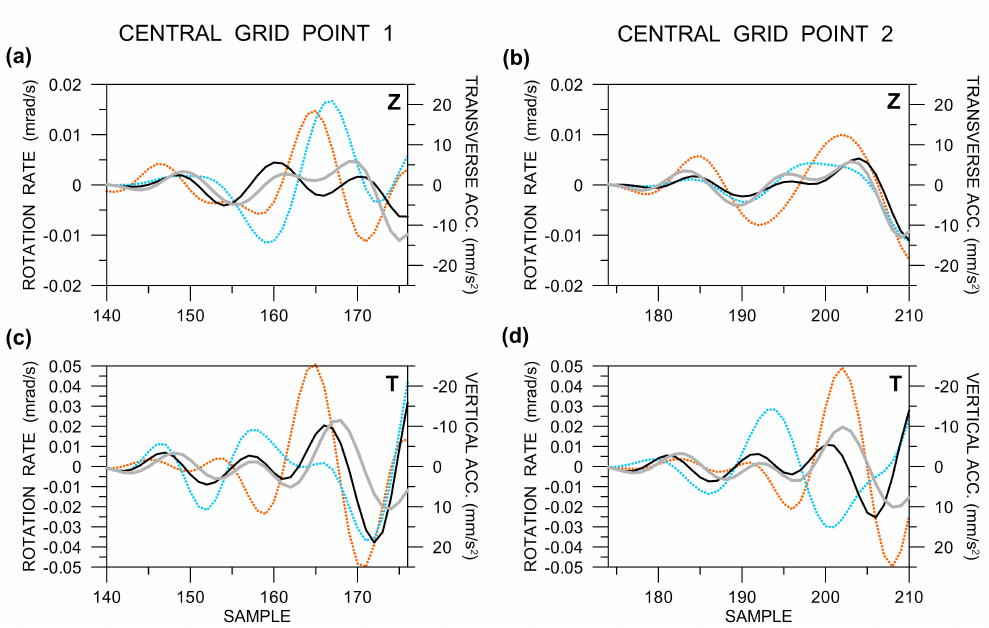
Figure 18. Comparison of the relevant acceleration and rotation rate components (vertical Z and transverse T) at the central grid points 1 ( a , c ) and 2 ( b , d ) in a short interval after the wave onset. Top ( a , b ): vertical rotation rate is compared to transverse acceleration, bottom ( c , d ): transverse tilt is compared to vertical acceleration. Colors: ADR—dotted orange, Rotaphone—solid black, R-1—light blue, acceleration—solid grey. Data are band-pass filtered between 6 and 20 Hz and instrument-corrected. The sampling frequency was 250 Hz. The amplitudes of the R-1 records are multiplied by the following normalizing factors: 10 (Z) in part ( a ), 1 (Z) in part ( b ), 5.3 (T) in part ( c ), and 1.8 (T) in part ( d